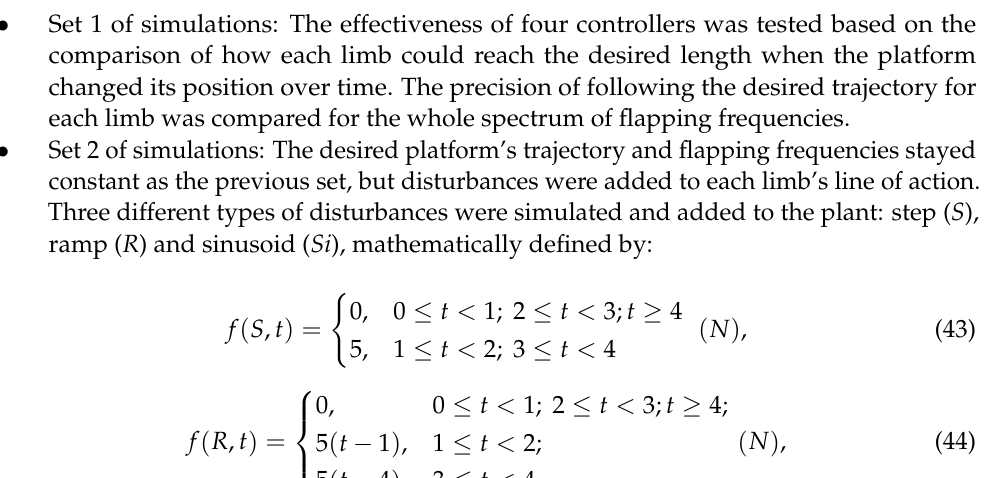
Table 3. Parameters for the implementation of simulations. Parameter Symbol Value Unit Actuator’s hull length. δ 0.068 m Distance from joint B i to Cm 2 Li . ε 0.025 m Mass of actuator’s hull. m 1 0.054 kg Mass of actuator’s piston. m 2 0.250 kg Platform’s moment of inertia. I P 1.09 × 10 − 4 Actuator’s hull inertial moment. I L Actuator’s piston inertial moment. I U 4.5 × 10 − 6 kg · m 2 Gravitational acceleration. g 9.81 m · s − 2 Proportional PD gain. kp 2500 - Derivative PD gain. kd 100